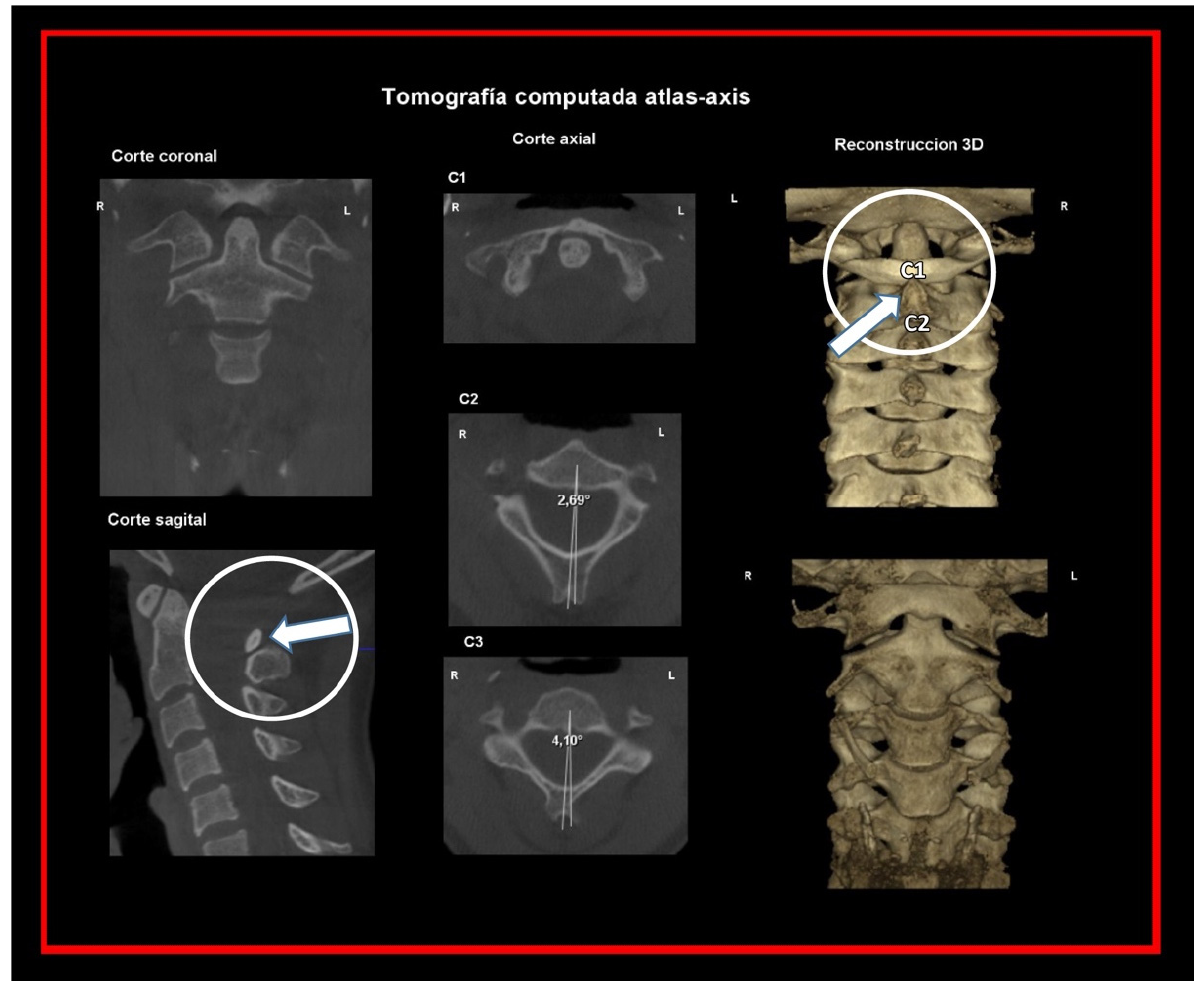
Figure 17. C 2 -C 3 segment. The angle of the spinous process of the axis determines the degree of axis rotation.